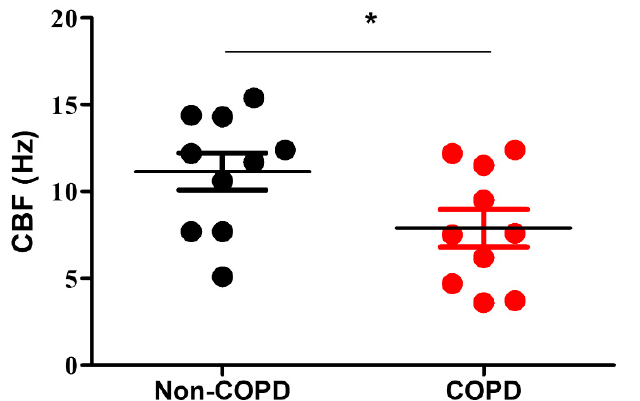
Figure 1. Cilia beat frequency of multiciliated cells is decreased in COPD patients. Dot plot (mean +/ − SD) showing the CBF in non-COPD (black, n = 10) and COPD (red, n = 10) AEC. *, p < 0.05 non-COPD vs. COPD.